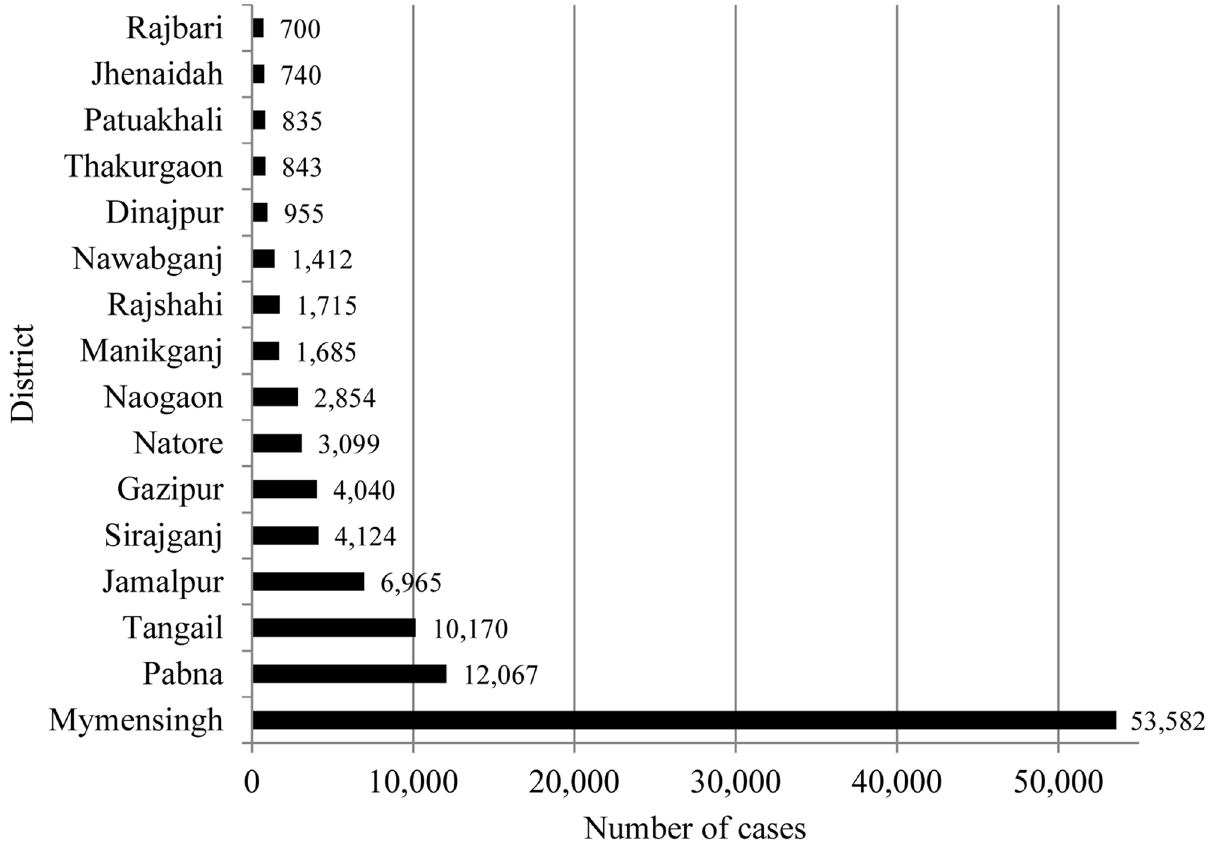
Figure 2. The 16 districts reporting VL cases consistently from 1994 to 2013. (Source: Malaria and Vector-Borne Disease Control Unit, Directorate General of Health Services, Government of Bangladesh, Dhaka).